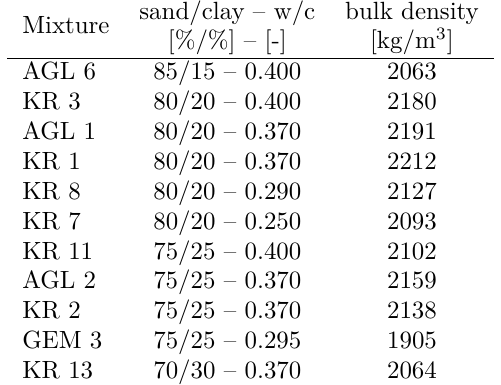
Table 1. Composition of mixtures and bulk density of